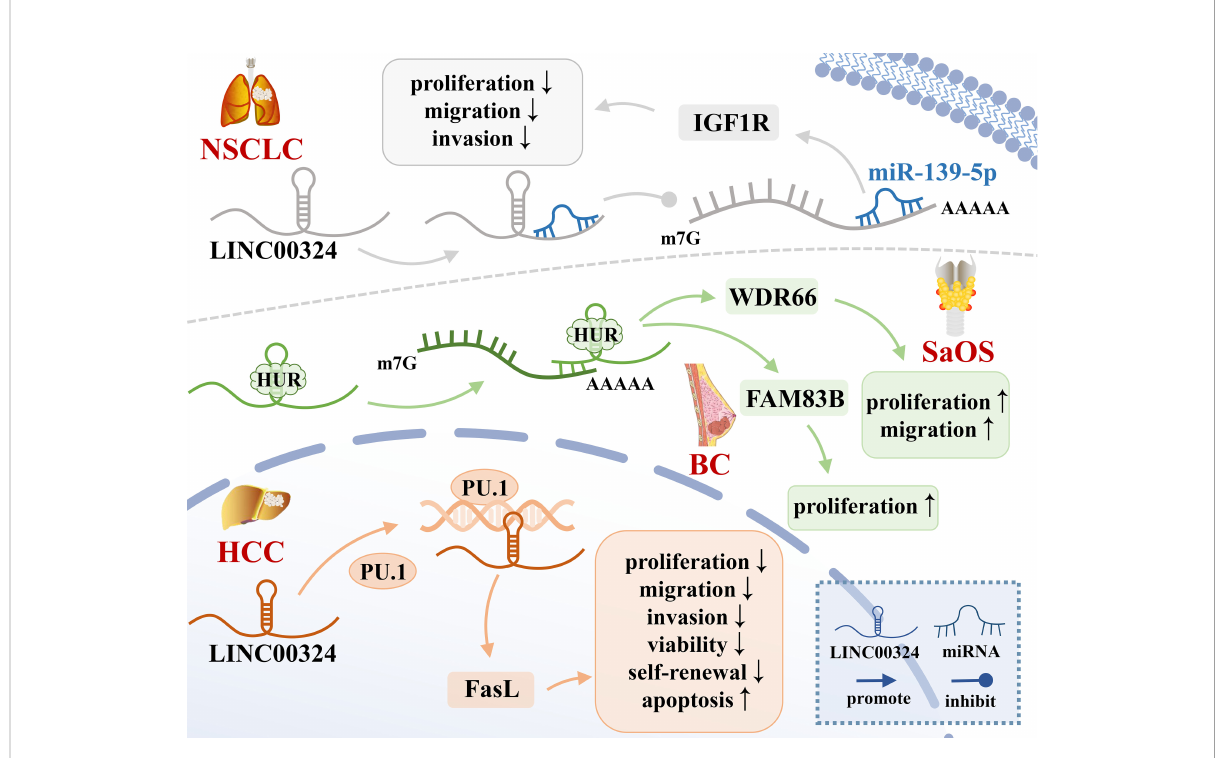
FIGURE 1 The mechanisms of LINC00324 in cancer. BC, Breast cancer; HCC, Hepatocellular carcinoma; NSCLC, Non-small cell lung carcinoma; SaOS, Osteosarcoma.